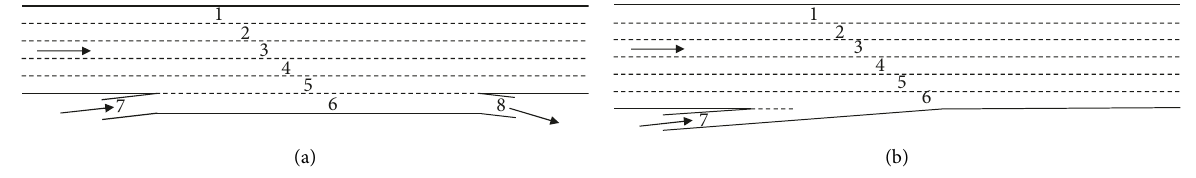
Figure 3: The schematic illustrations of dataset. (a) US-101 dataset; (b) I-80